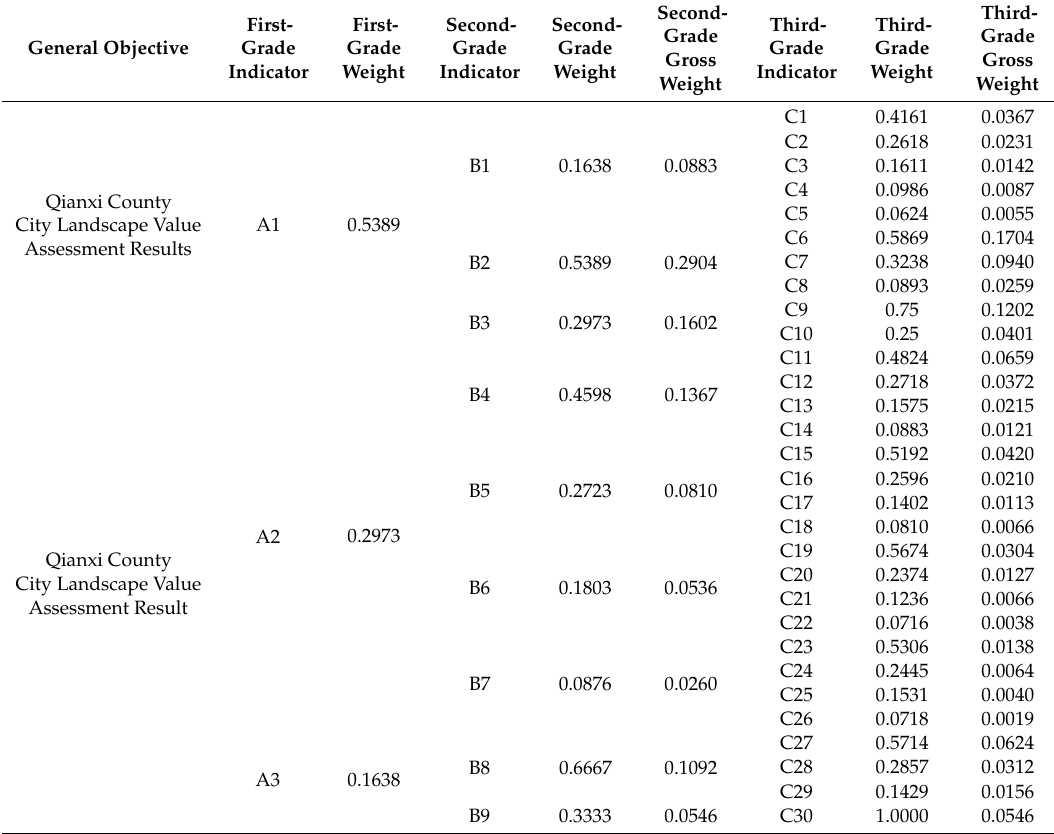
Table 5. Qianxi County City Landscape Value Assessment